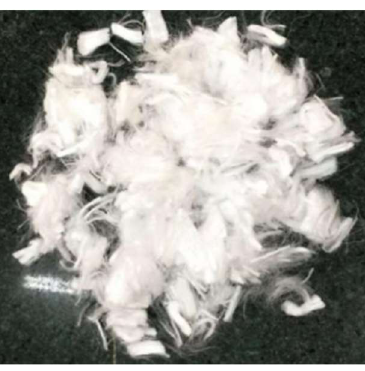
Figure 1. Polypropylene fiber. Table 2. Physical and mechanical parameters of polypropylene